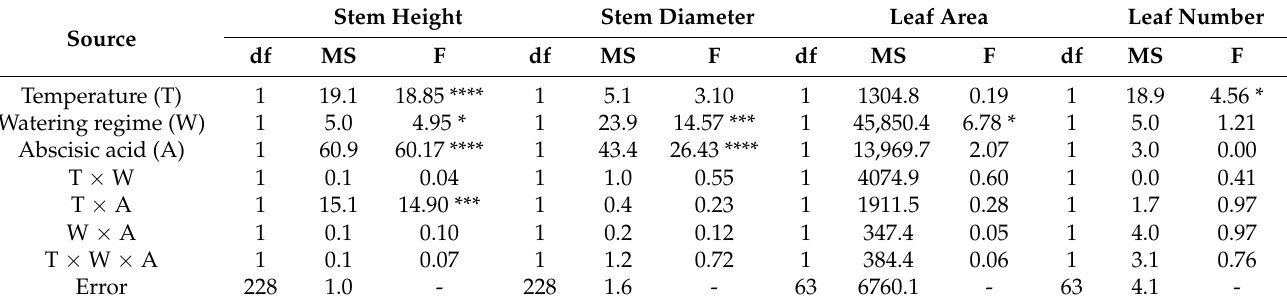
Table 1. Analysis of variance for the effects of temperature, watering regime, abscisic acid, and their interactions on stem height, stem diameter, leaf area, and leaf number of tomato